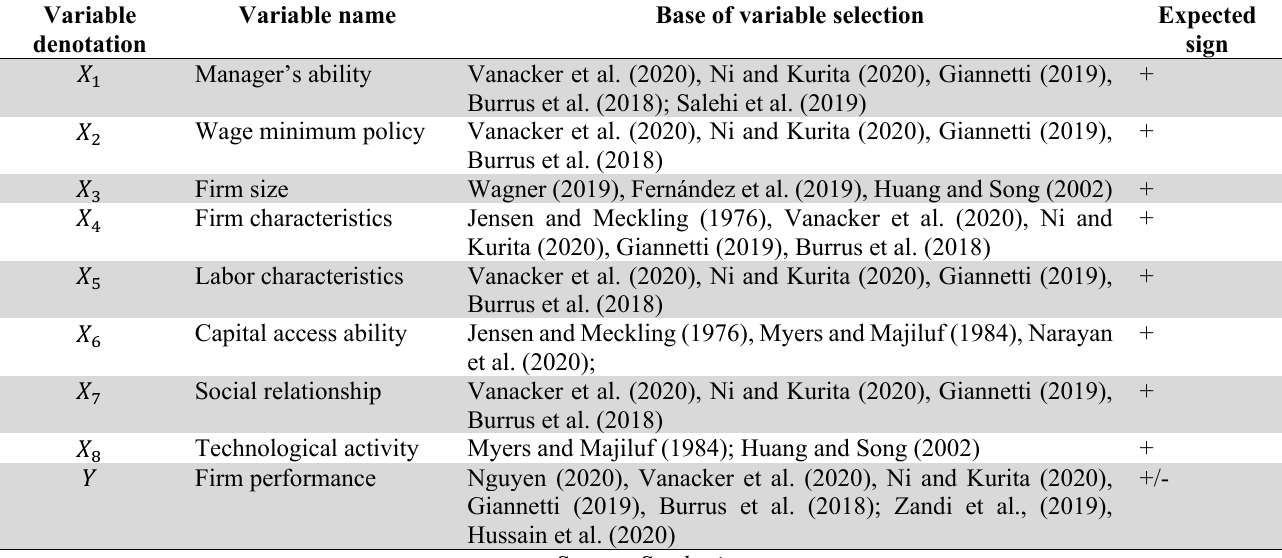
Summary of variables in the research